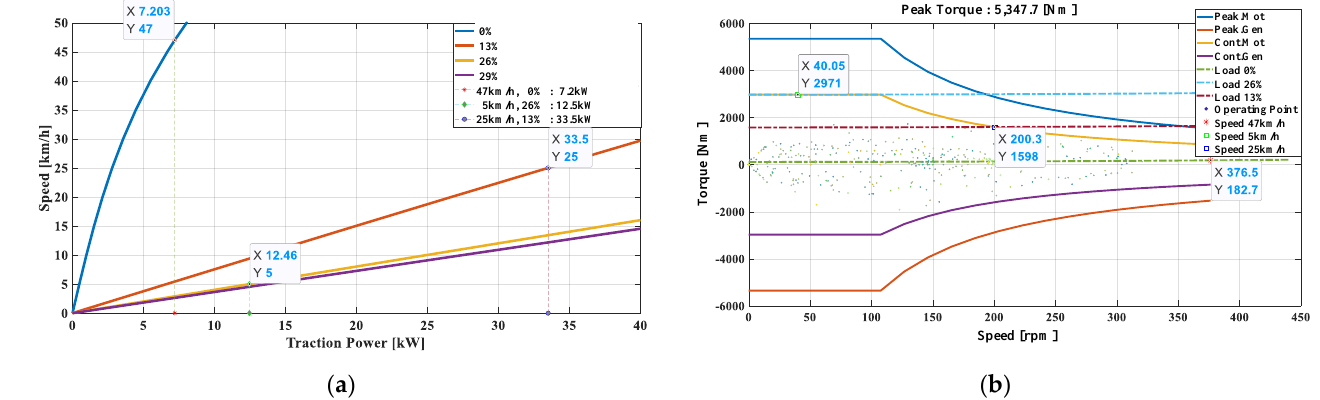
Figure 3. Sizing results of ( a ) power-gradient-speed and ( b ) torque-speed chart with the requirement point. Table 4. Unit propulsion system requirements.